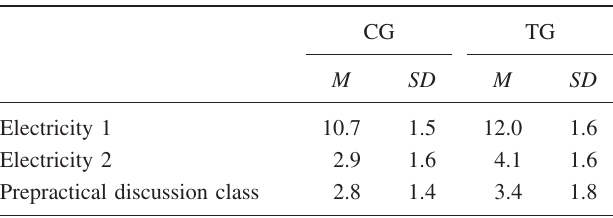
TABLE VI. Average time interval M in days between the as- sessment and the physics experiments “Electricity 1,” “Electricity 2” and the pre-practical discussion class for the classes of the con-